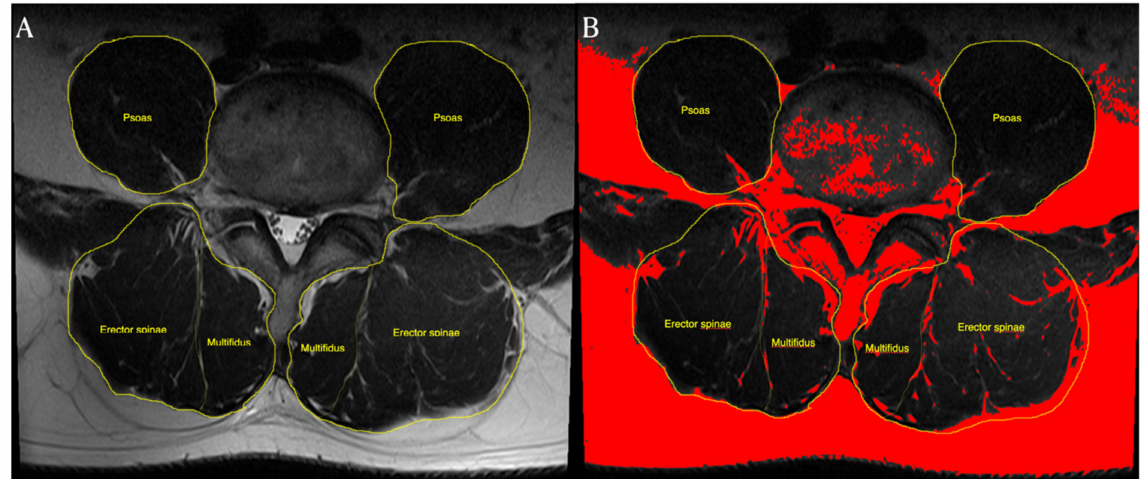
Figure 2. We defined the back muscles as consisting of the multifidi and erector spinae muscles. This region was manually traced. The CSA of the back muscles and multifidi were measured separately: ( A ) the rate of fat infiltration was measured using the pseudocoloring technique in the software. Fat tissue on axial T2-weighted MR image was converted to red. We calculated the portion of red area among the CSA of back muscles ( B